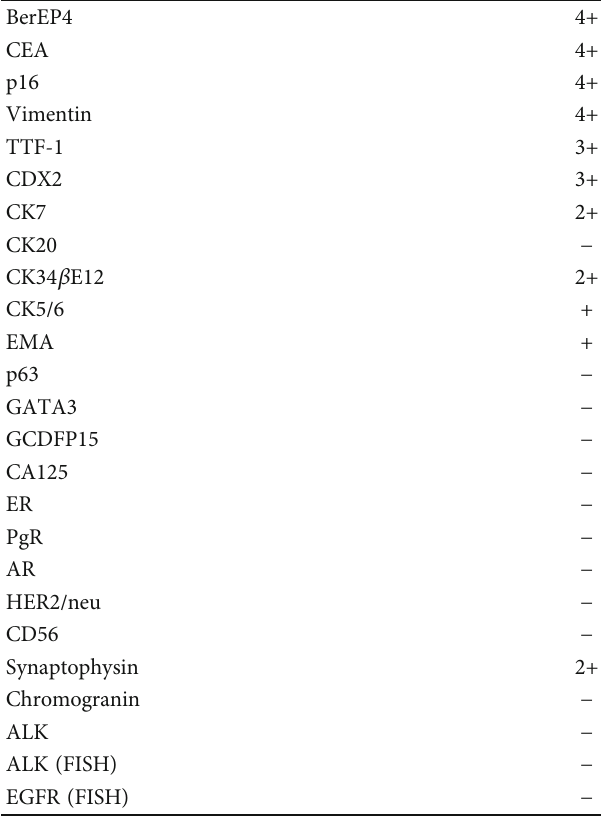
Figure 5: (a) Low-power view of the vaginal tumor. Malignant cells in fi ltrated into submucosal tissues, forming tumor nests. (b) High- power view. Undi ff erentiated cells surrounded a necrotic cluster. Table 1: Immunohistochemical expression of the tumor